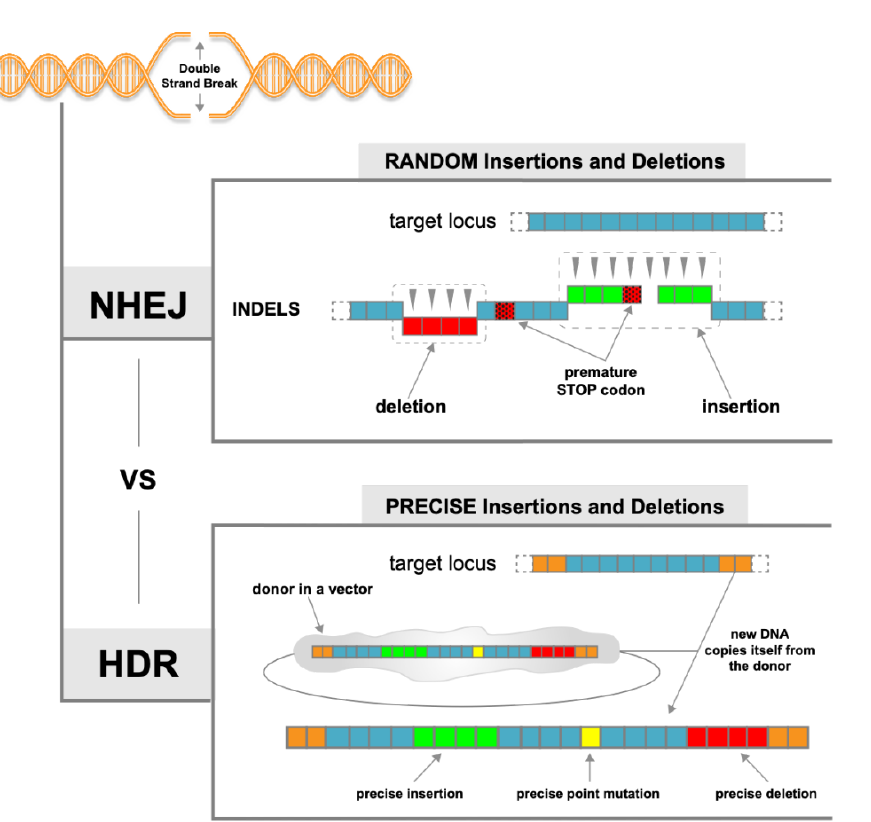
Figure 1. Major DNA repair pathways. Double-stranded breaks are repaired by the error-prone non-homologous end joining (NHEJ) or the precise homology-directed repair (HDR) pathways.